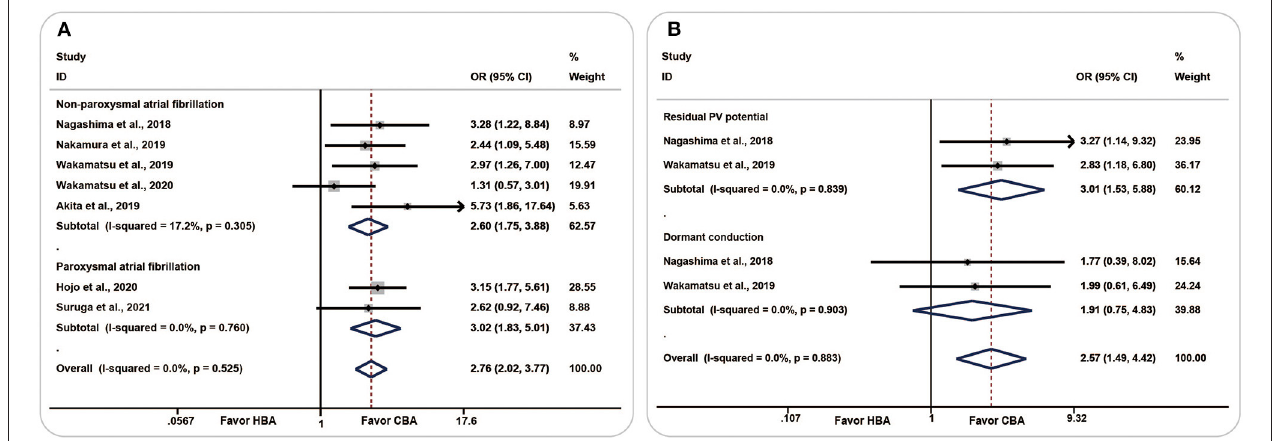
FIGURE 2 | Forest plots showing the association between touch-up ablation and ablation strategy. (A) Touch-up ablation, (B) residual conduction. CBA, cryoballoon ablation; HBA, hot balloon ablation.